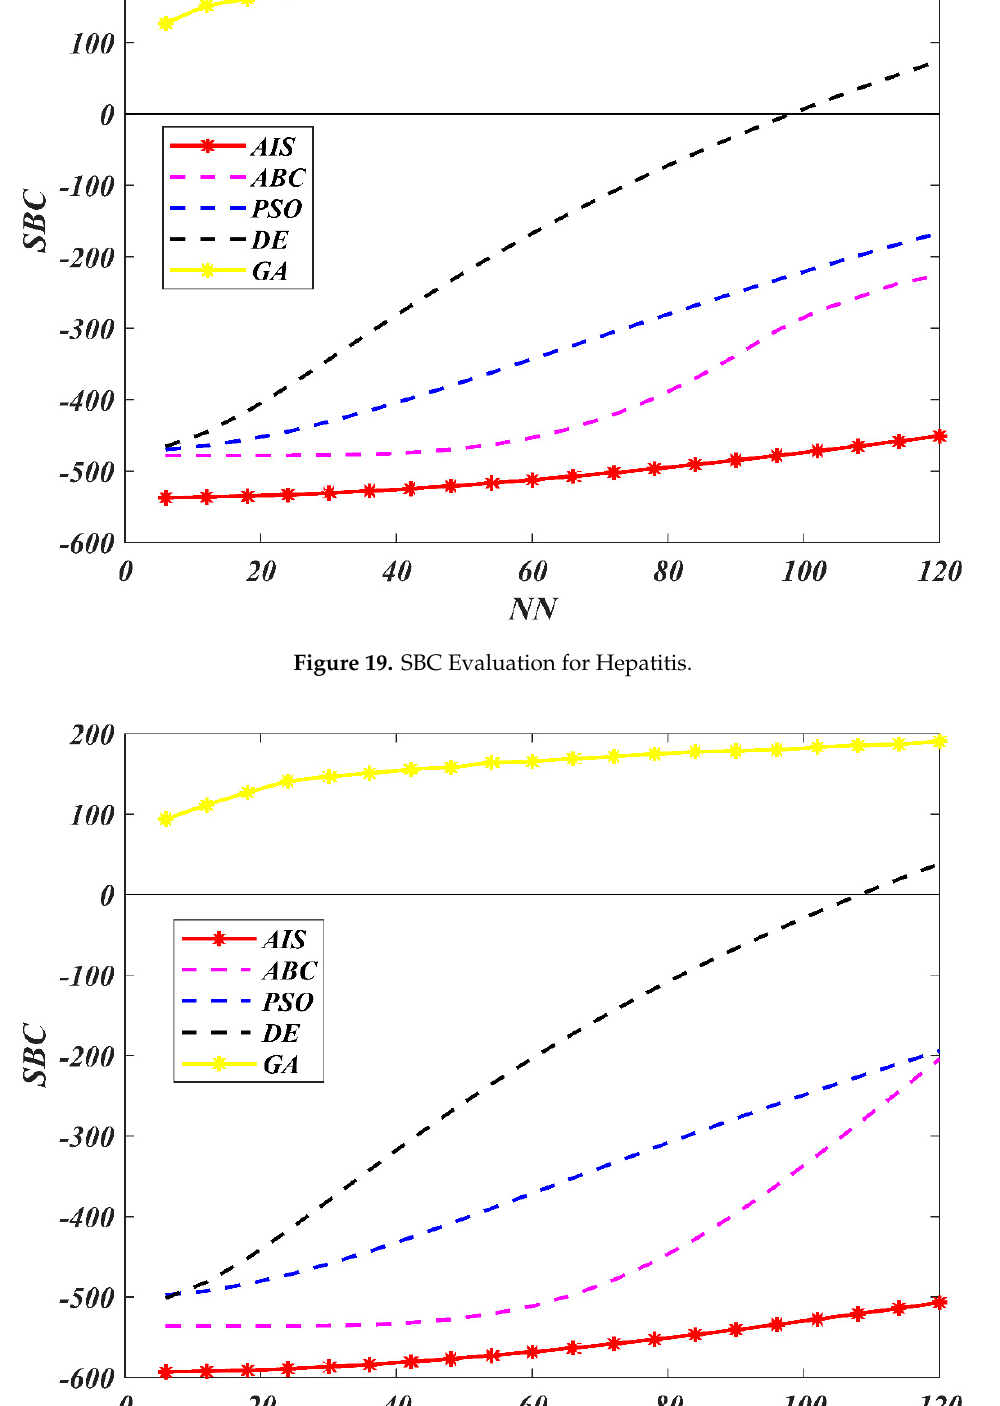
Figure 20. SBC Evaluation for Congressional Voting Records.